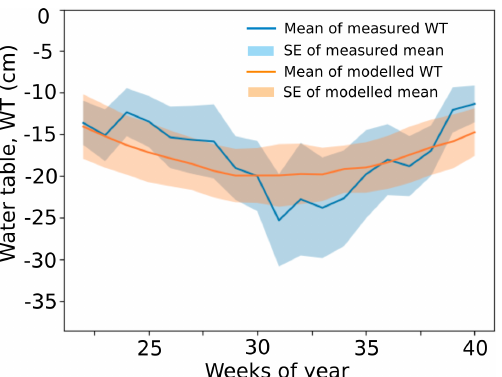
Figure D1. Comparison of the seasonal water table (WT) measured at the Lakkasuo study site and the values simulated by the calibrated PMS. WT values were sampled weekly from the lawn habitats both in the field and in the model output. The weekly mean WT was measured during 2001, 2002, 2004, and 2016. The modelled means and standard deviations (SD) of the WT were based on 20 Monte Carlo simulations. The simulated seasonality of the mean WT generally followed the measured trends. The calibration reduced the sum of squared error (SSE, Eq. 12) from 199.5 ( a N = b N = 0) to 117.3. The calibrated values for a N and b N were − 5 . 3575 × 10 − 4 and 4 . 7599 × 10 − 5 respectively (Eq.